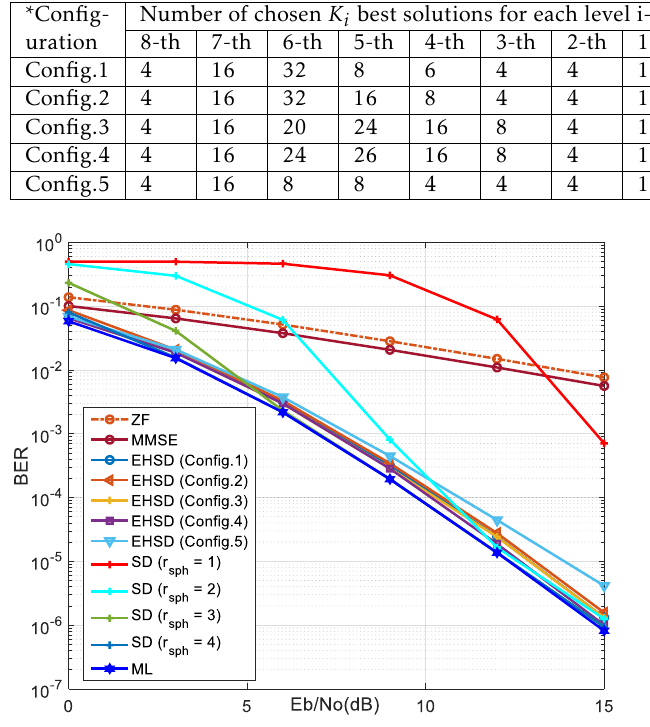
Figure 7. BER performance Comparison different